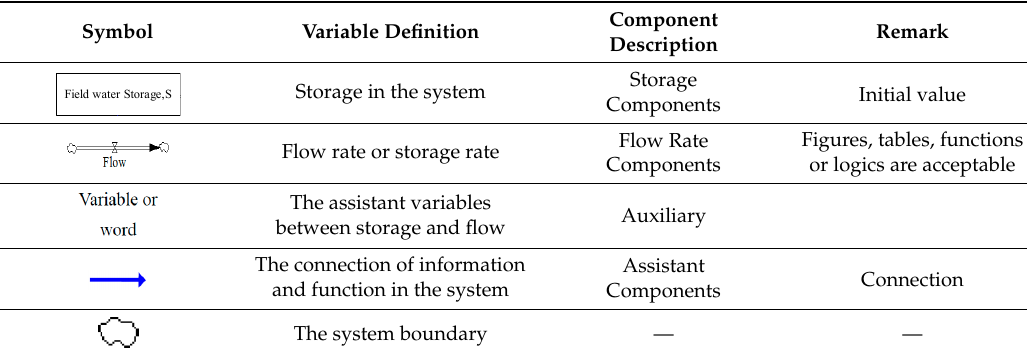
Figure 9. Water usage sequence of model establishment. The water flows with the block sequence, shown in Figure 10. If the depth of rainfall is less than the height of the outfall, there is no overflow to drain. However, if the rate of the rainfall is greater than the drain from the outfall, the water level may exceed the effective height of the ridge and overflow occurs. The water drains to the nearby field drain and converges to the main drain, Chao- Yang second drainage channel. Figure 10. Flow direction of each block and sub-block in the study region.